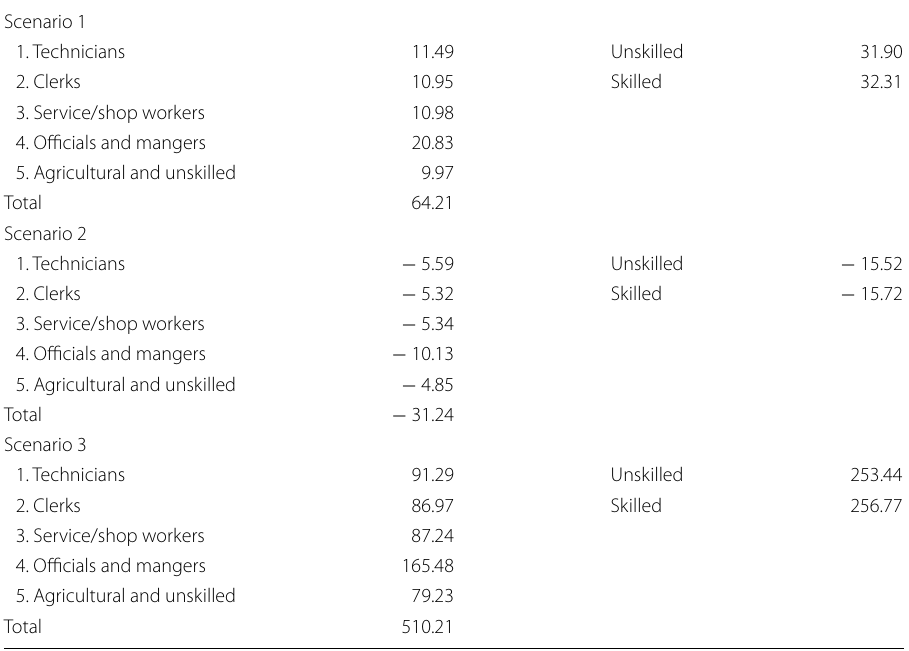
Table 13 Additional labour force generation in different scenarios without USA (in thou- sand)